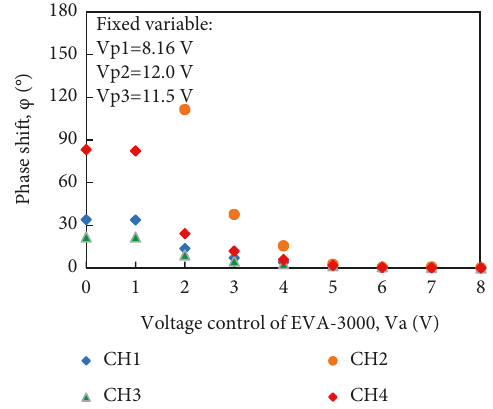
Figure 18: Output phase, ø p, of each channel when V aq varies from 0 to 8 V and V pp is kept constant.